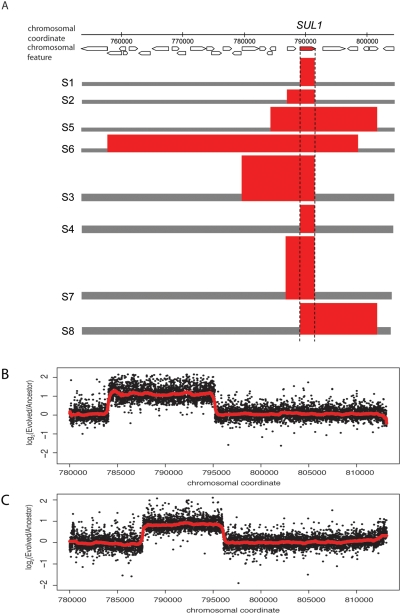

SUL1 is amplified in multiple independent evolutions.(A) Amplified fragments that include the gene SUL1 were identified in clones recovered from all sulfate evolutions. Amplicons, in red, span the length of the CGH signal deviation from wildtype ploidy (in gray). The height of the amplicon reflects the copy number relative to wildtype (gray bars, height scaled to haploid or diploid copy number as appropriate). The number of copies of amplified fragments was determined by averaging CGH data from two clones from each population, with the exception of populations S1 and S2, in which only one clone was used due to disagreement between the clones. We analyzed two of these amplicons in further detail using a high density overlapping tiling microarray. The breakpoints for SUL1 amplifications were precisely mapped in the haploid clone S2c1 (B) and the diploid clone S4c1 (C). Complete data are shown for the ratio between independent hybridizations of evolved and ancestral DNA for the 7356 probes that span chromosomal coordinates 780003-813512 of chromosome II. A running median was computed using the R function runmed with a median window width of 201 (red line).